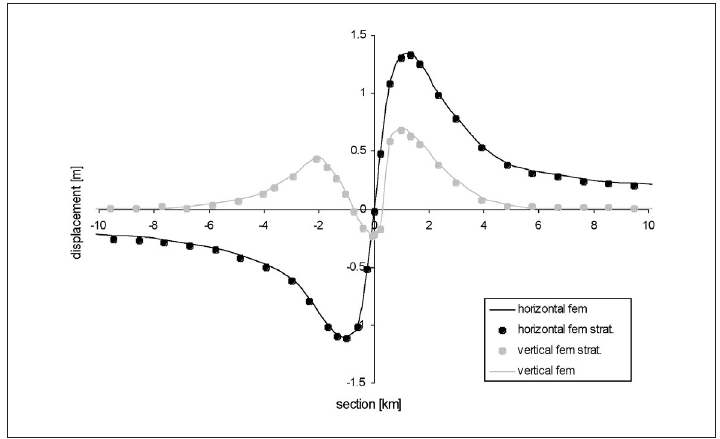
Fig. 6. Comparison between the deformation field of the tensile crack in a homogeneous medium ( i.e. without stratifications) with topography and one in a stratified medium with topography. The top of the crack is posi- tioned at 1420 m a.s.l., the geometric parameters are in table I.